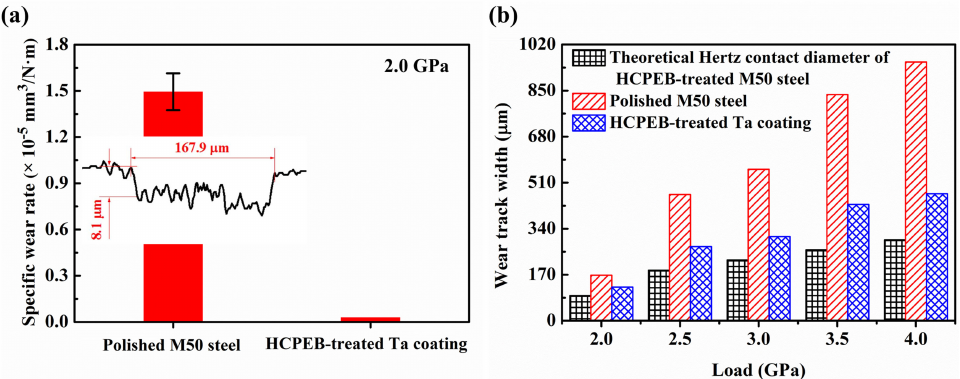
Figure 10. Wear loss characterization of bare (polished) M50 steel and HCPEB-treated Ta coating after sliding in pure JP-10 against a Si 3 N 4 ball at room temperature in ambient atmosphere: ( a ) specific wear rate under 2.0 GPa (the inset is the wear profile of M50 steel); ( b ) wear track width under 2.0–4.0 GPa. Relative error of wear track width at different positions is less than